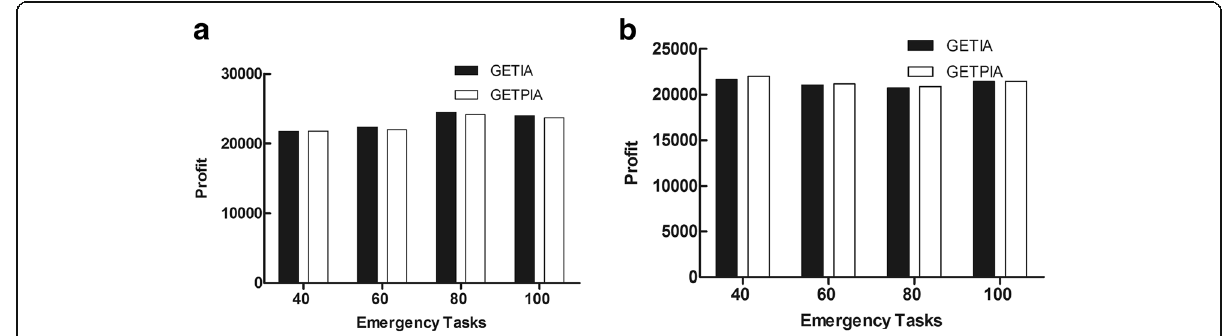
Fig. 8 Revenue comparison under 200 original tasks ( a , b )